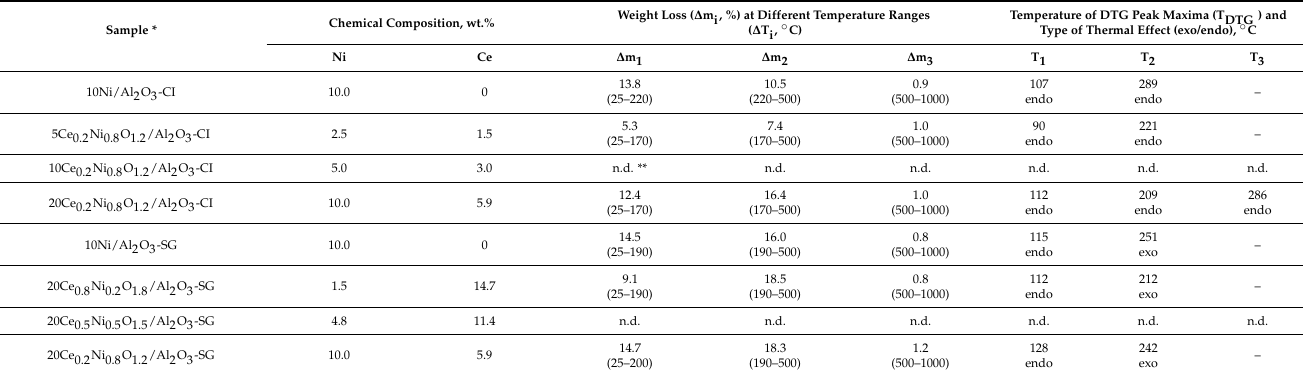
Table 1. Chemical composition of Ce 1 − x Ni x O 2 − x /Al 2 O 3 catalysts and data of the thermal analysis of dried